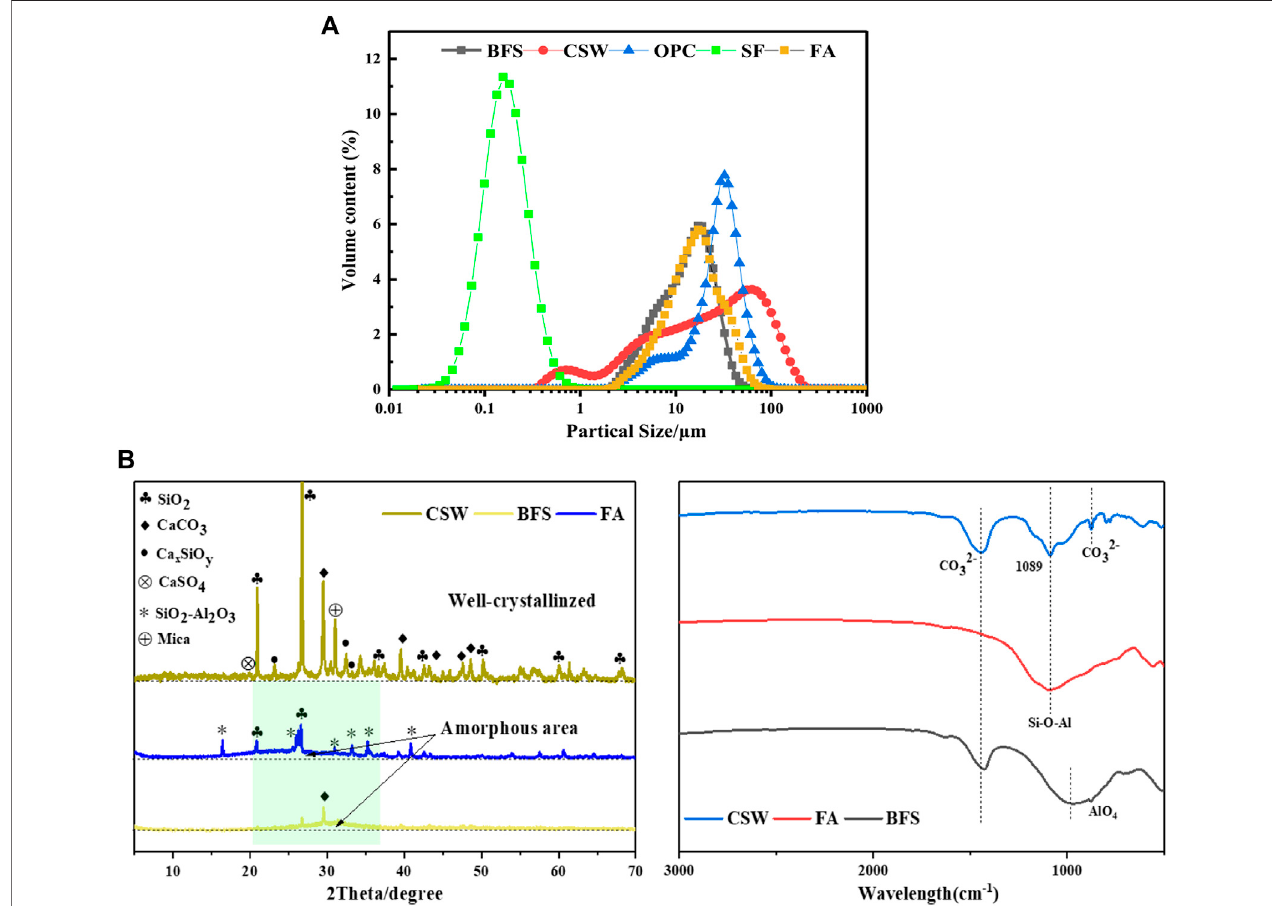
FIGURE 2 | Basic characteristics of raw materials.